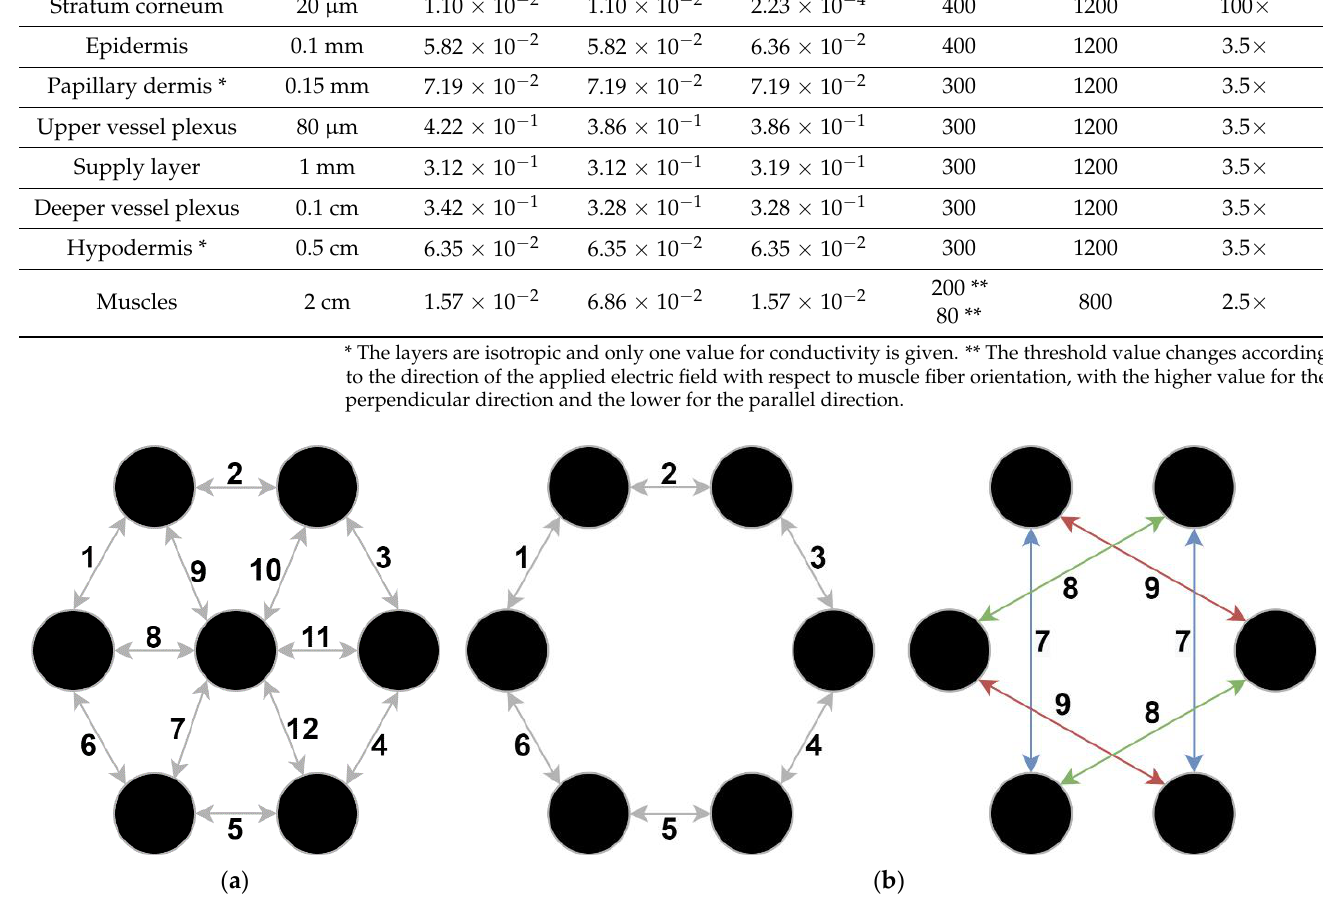
Figure 1. The order of pulse delivery for ( a ) the classical pulse delivery protocol and ( b ) the proposed alternative pulse delivery protocol. The numbers indicate the order of pulse delivery. The arrows indicate the direction of the applied pulse (anode -> cathode).